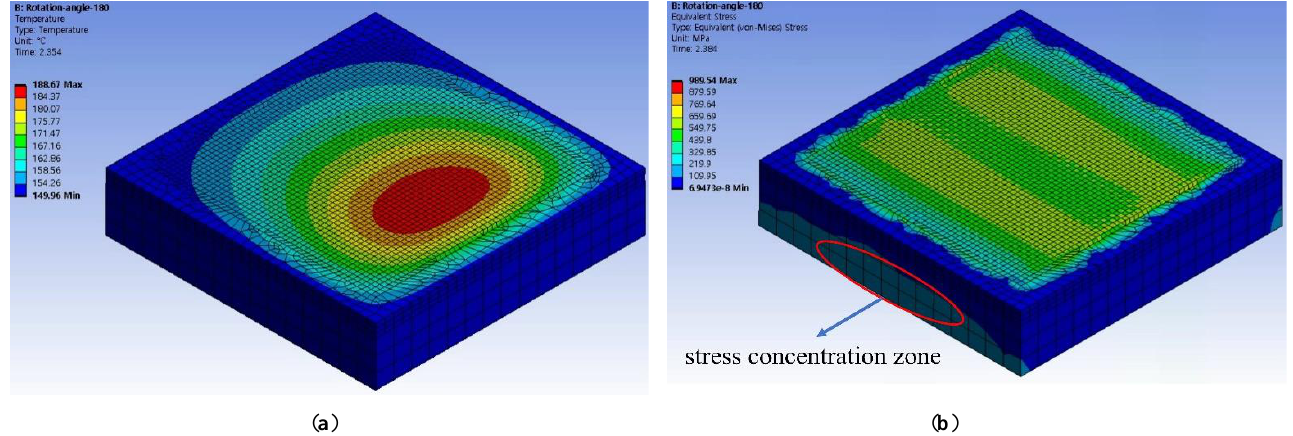
Figure 7. Simulation results of three-layer additive process: ( a ) Temperature; ( b ) residual stress.